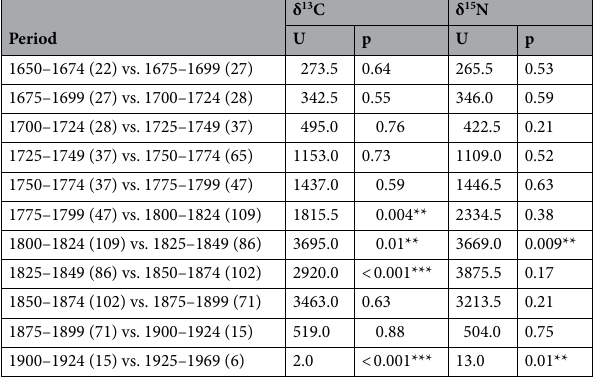
Table 3. Significance of differences between 25-year periods in isotope values (Mann–Whitney U test). Number of samples in parentheses. *p < 0.05, **p < 0.01, ***p <